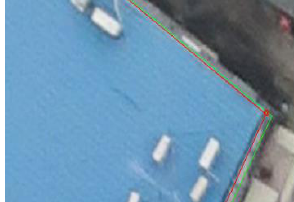
Figure 12. Areas with low horizontal accuracy between adjacent models